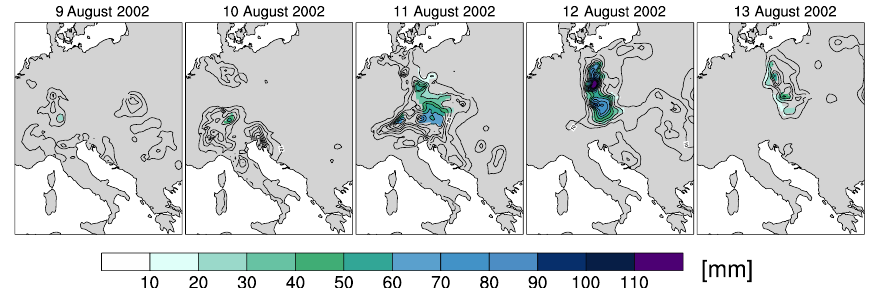
Figure 3. Precipitation for the period 9 to 13 August 2002 based on the E-OBS data set. Contour lines show daily precipitation amounts. Colour denotes grid boxes in which the local 10-year return levels are